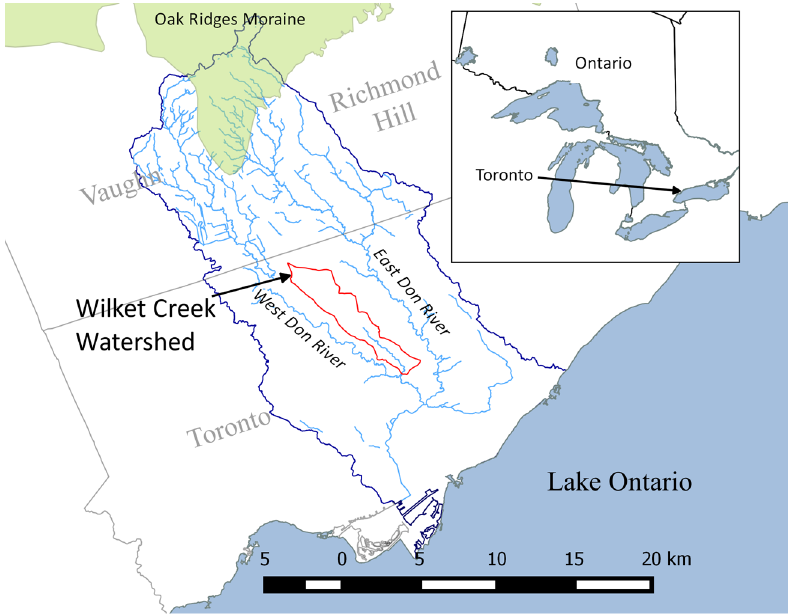
Figure 1. Geographical context of the Wilket Creek watershed. GIS layers were provided by the Toronto Region Conservation Authority.